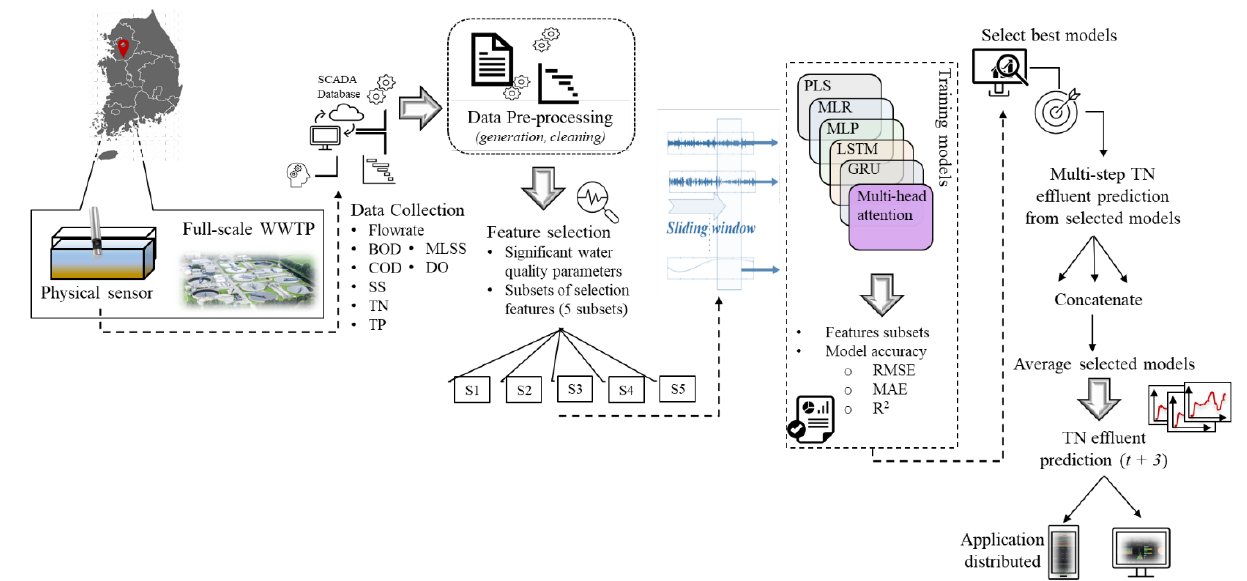
Figure 7. Conceptual configuration of proposed multistep effluent TN prediction at full-scale WWTP.